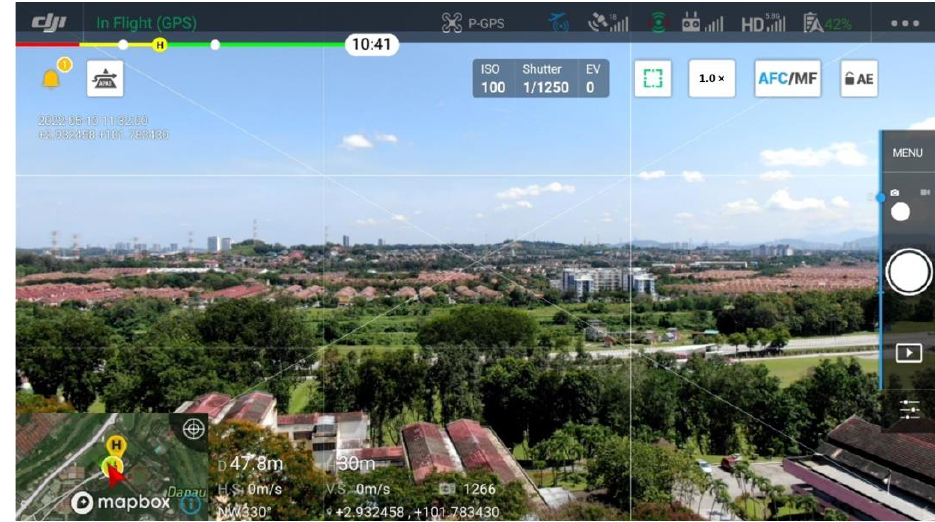
Figure 3. Overview of the suburban study environment for the 4G dataset measurement. Table 2. Physical information of the considered BSs.